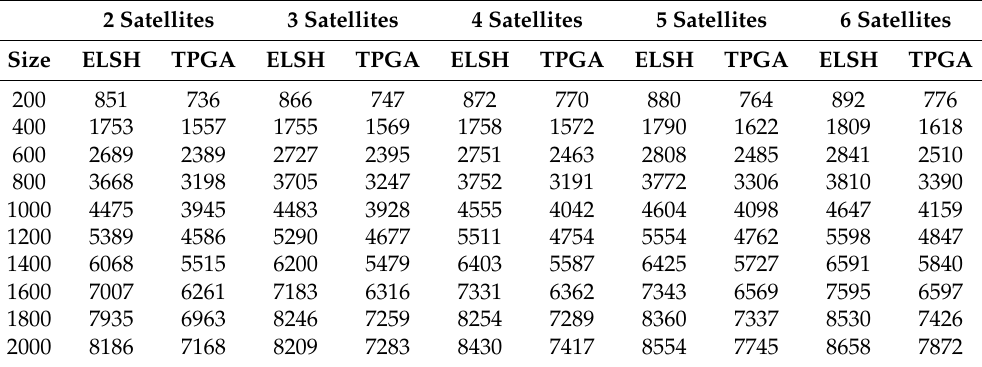
Table 6. Comparison with TPGA on the total profit on world distribution